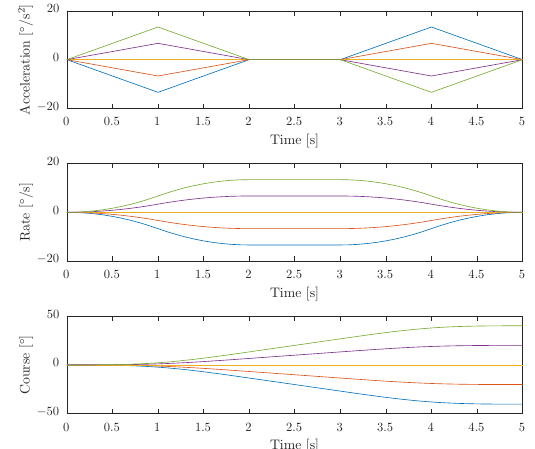
Figure 4: Example of 5 course trajectories with ramp time 1 s, and maneuver and step time lengths 𝑇 ramp = 𝑇 𝑇 = 5 s. Acceleration is shown in the top 𝜒 = plot, rate in the middle plot and course in the bot- tom plot. Courtesy of (Eriksen et al., 2019b). trajectory tree depth 𝐵 ( 𝐵 maneuvers in each trajectory), this leaves us with deciding the step time lengths of each level 𝑻 = [ 𝑇 1 ,𝑇 2 , . . . ,𝑇 𝐵 ] , and the number of speed and course maneuvers at each level 𝑵 and 𝑁 , 𝑁 , . . . , 𝑁 𝑈 = [ 𝑈, 1 𝑈, 2 𝑈,𝐵 ] 𝑵 𝜒 = [ 𝑁 𝜒, 1 , 𝑁 𝜒, 2 , . . . , 𝑁 𝜒,𝐵 ] . A set of feedback-corrected predicted pose trajectories for a trajectory generation with 𝐵 = 3 levels is shown in Figure 6. The ramp time is 𝑇 1 s, and the speed and ramp = course maneuver lengths are 𝑇 5 s. The step time 𝑇 𝑈 = 𝜒 = lengths are 𝑻 = [ 20 , 30 , 30 ] s, and the number of speed and course maneuvers are 𝑵 1 , 1 , 1 ] and 𝑵 5 , 3 , 3 ] 𝑈 = [ 𝜒 = [